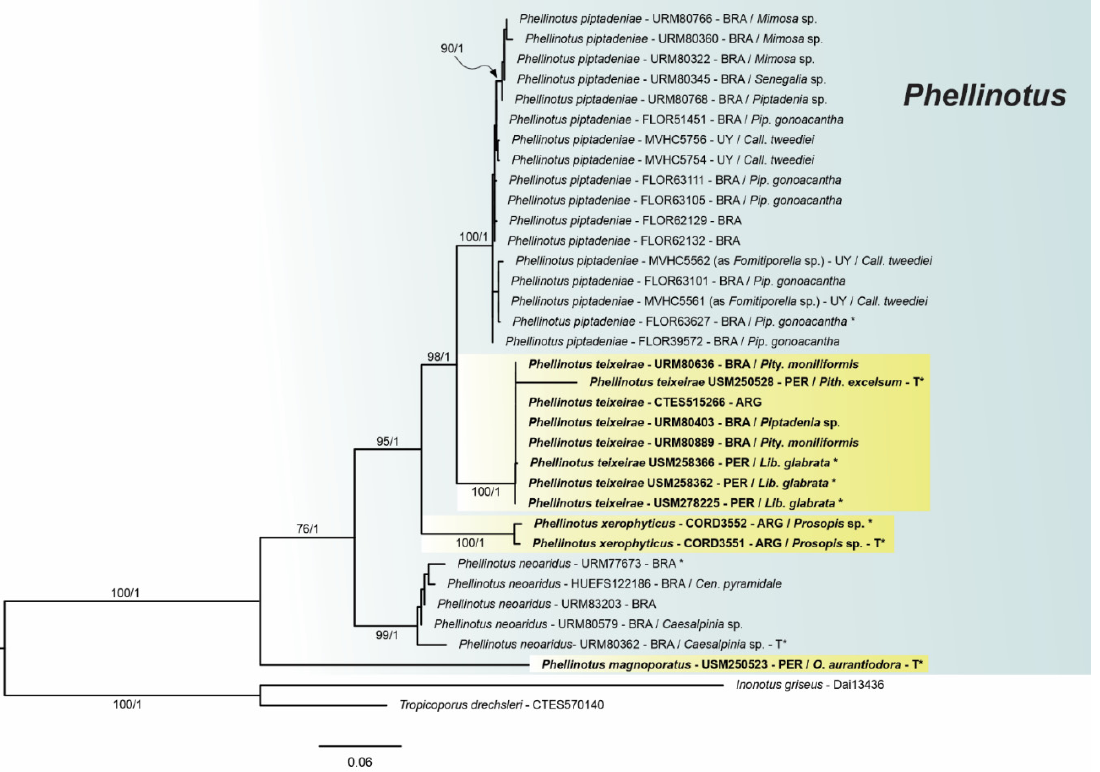
Figure 2. Maximum Likelihood (ML) tree of Phellinotus from the dataset of 35 combined sequences ( nLSU + nITS +TEF1- α +RPB2). Bootstrap values above 60% and Bayesian posterior probability above 0.8 are shown. Bold font is used to indicate the newly described species. Pip . = Piptadenia , Call . = Calliandra , Pity . = Pityrocarpa , Pith . = Pithecellobium , Lib . = Libidibia , Cen . = Cenostigma , O . = Ocotea , T = material type, * = specimen of local type, BRA = Brazil, UY = Uruguay, ARG = Argentina, PER = Peru.